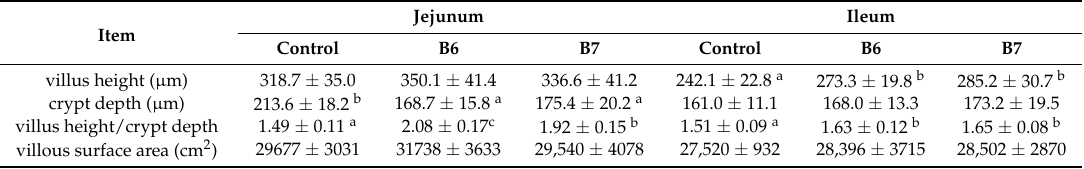
Table 3. Effects of B. coagulans on the intestinal morphology of weaned